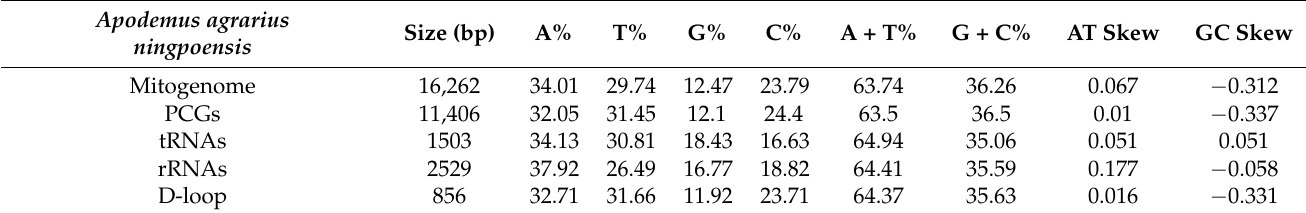
Table 3. Base content of the mitochondrial genome of Apodemus agrarius ningpoensis